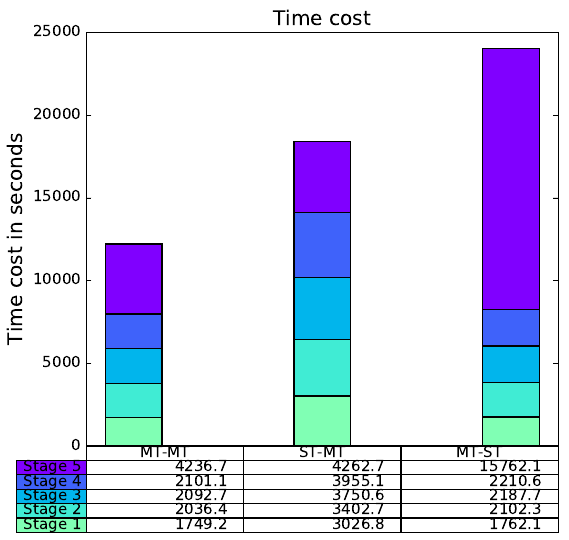
Figure 16. Time cost of BiBulk_FFBP in different executing environments. Stages 1–4 represent the factorization step, and Stage 5 is the subsequent focusing with BP. (MT: multi-thread; ST: